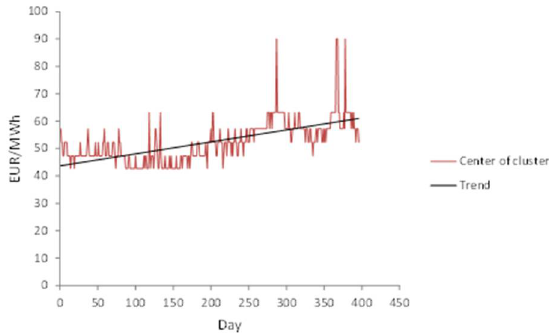
Figure 6. Trend of fuzzy time series monitored electricity price time series to interval-valued time series.